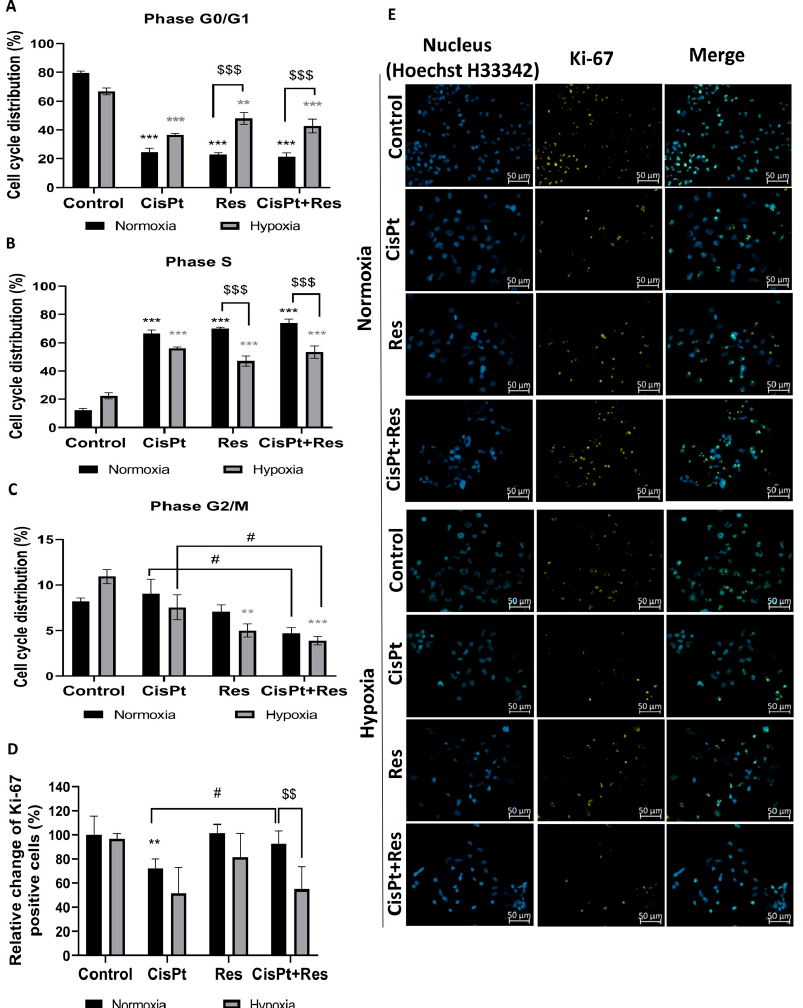
Figure 4. Modification in the distribution of the cell cycle phases and Ki-67 expression after treatment of A2780 cells with cisplatin, resveratrol, and in combination in normoxia and hypoxia. The cells were treated according to Section 4.4: Establishment of Hypoxic Culture Conditions and Experimental Outline, before staining with propidium iodide (PI). The percentage of cells in a given phase of the cell cycle was analyzed by fl ow cytometry. Graphs show the percentage of cells in the ( A ) phase G0/G1; ( B ) the S phase; ( C ) the G2/M phase of the cell cycle. Panel ( D ) shows the relative change of Ki-67 positive cell percentage compared to the 100% normoxia control. ( E ) Representative images of Hoechst nuclear staining and Ki-67 staining after treatment with cisplatin (CisPt), resveratrol (Res), and CisPt+Res (Zeiss Axio Observer, magni fi cation 40×, scale bar is equal to 50 µm). Data are representative of at least three repeats. The results are presented as the mean ± SEM values. *** p < 0.001, ** p < 0.01, vs. normoxia control (black asterisk) and grey asterisk vs. hypoxia control; $$$ p < 0.001, $$ p < 0.001, comparing the normoxia group with hypoxia group; and # p < 0.05, CisPt alone vs. CisPt+Res.